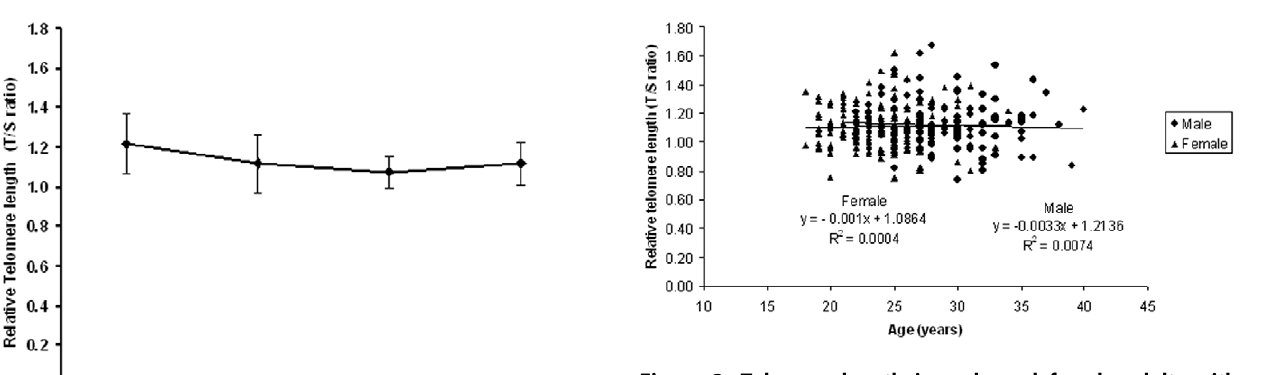
Figure 3. Telomere length in male and female adults with respect to age.